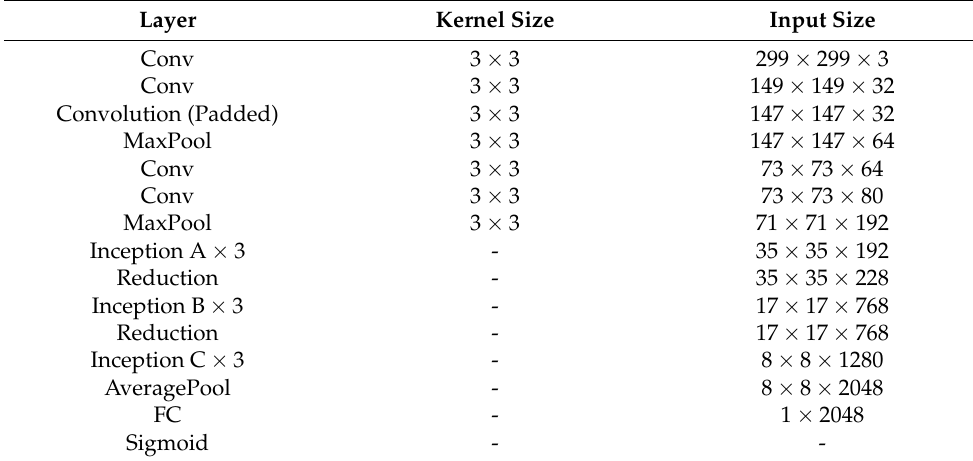
Table 2. Inception-V3 CNN